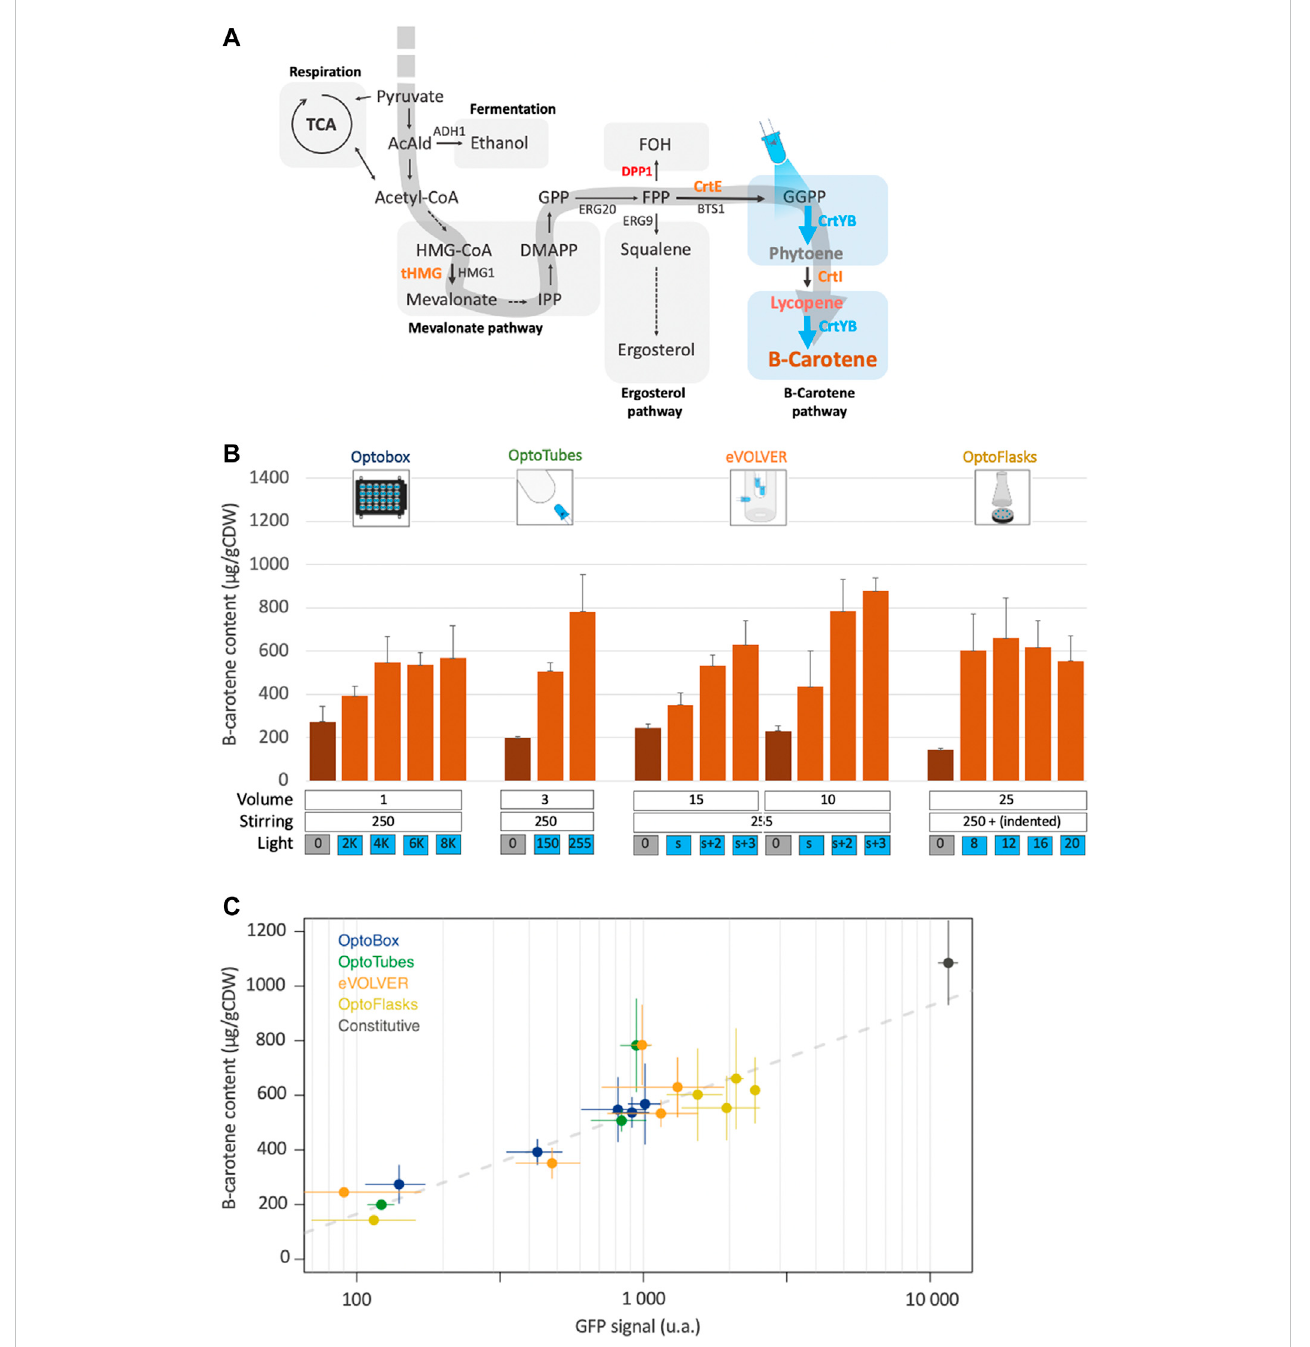
FIGURE 4 Light-activatedbeta-caroteneproduction. (A) Designleadingtolightcontrolledbeta-caroteneproduction:intheoptogeneticstrain,onlyCrtYBisunder thecontrolofthepC120promoter(yPH_551).Bluearrowsrepresentlight-inducedenzymaticreactions.Orange:heterologouscarotenogenicgenesinserted under constitutive promoters. Red: deleted endogenous genes. Blue: optogenetically controlled reaction. (B) Beta-carotene production quanti fi cation from the different devices. Dark-orange bars correspond to cultures in the dark, light-orange bars correspond to illuminated cultures. Volumes (mL), stirring (rpm except u.a. for eVOLVER) and illumination (u.a.) are indicated ( n > 3). (C) Light-activated beta-carotene production (Figure 4B) versus corresponding optogenetic activation (from Figures 2C – F — note the log 10 scale) in the different devices. Grey dashes represent the linear regression fi t (adjusted R 2 = 0.81). The black point represents the pTDH3 promoter GFP signal and production by the constitutive beta-carotene production strain (yPH_554 — Figure 3C). Error bars are standard